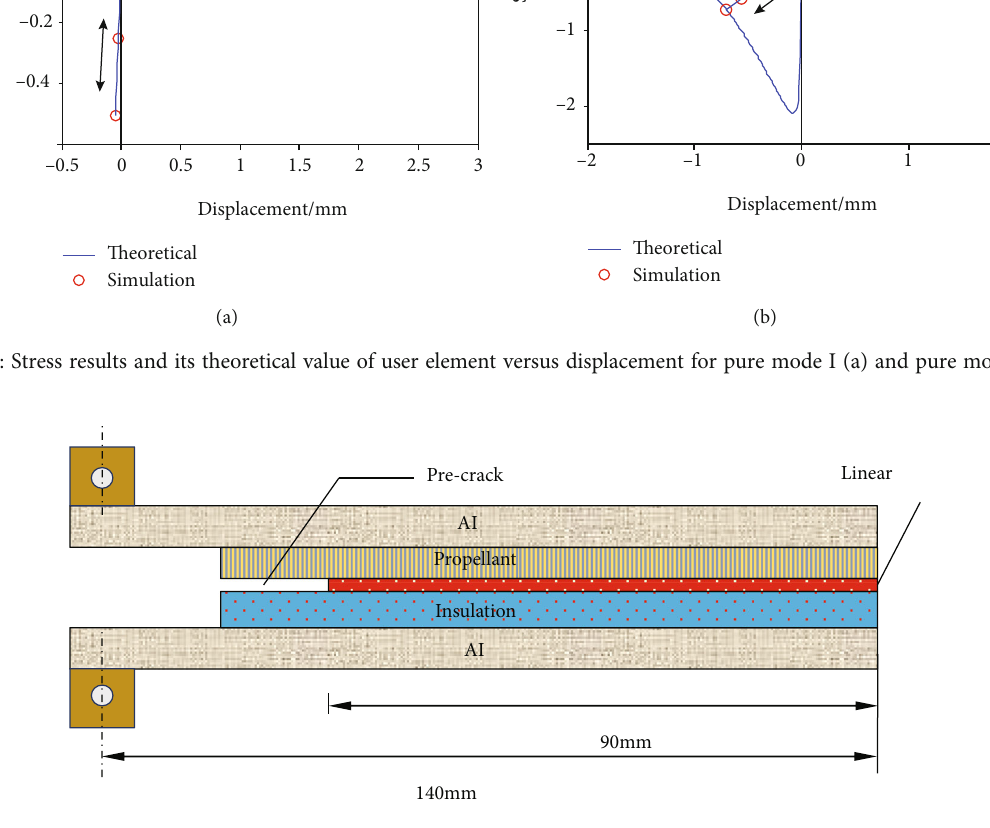
Figure 10: Geometry of the DCSB test for the propellant and insulation interface. Table 1: Parameters in the Prony series for HTPB propellant stress relaxation experiment.